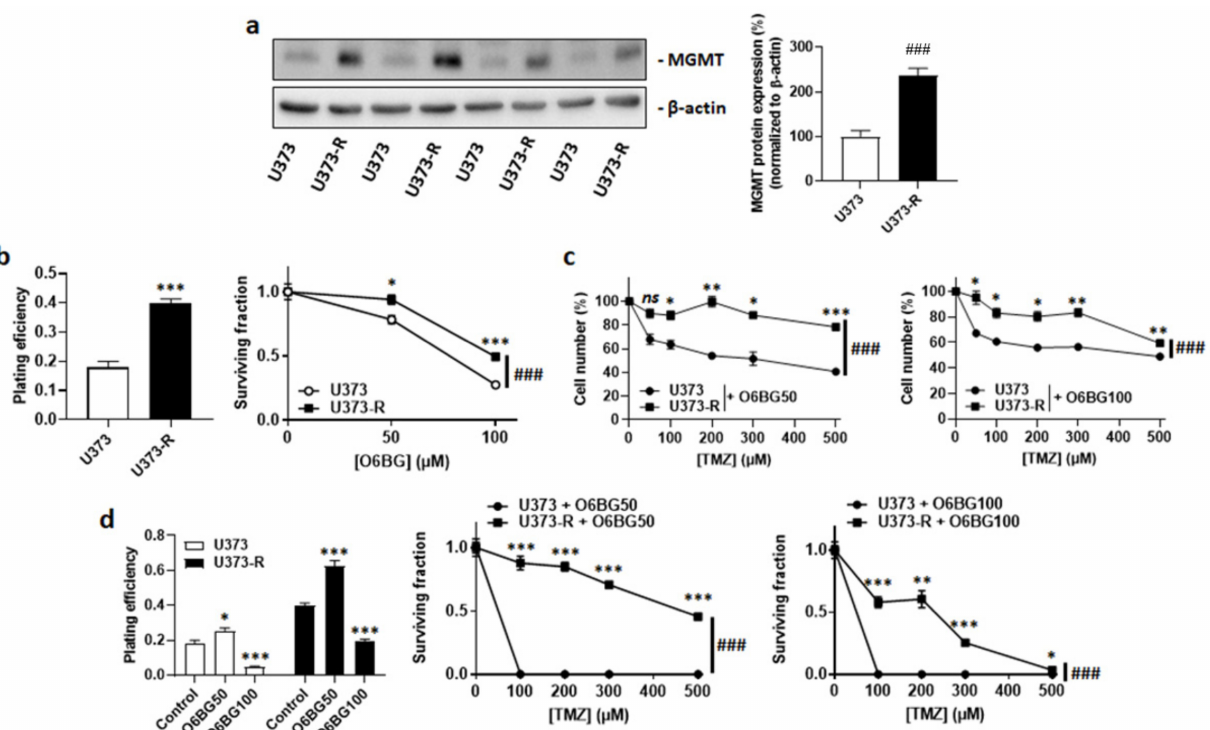
Figure 2. High MGMT protein expression does not account for TMZ resistance in the U373/U373-R isogenic human glioblas- toma model. ( a ) O6-methylguanine DNA methyltransferase (MGMT) and β -actin (loading control) protein expression as determined by Western blotting in U373 and U373-R glioblastoma cells in the absence of TMZ, with pictures on the left and quantification on the right ( n = 4). ( b ) Clonogenic assays of the cells that were pretreated for 72 h with increasing concentrations of MGMT inhibitor O6-benzylguanine (O6BG). Displayed are the plating efficiency of the vehicle-treated cells at 72 h ( left ; n = 6); and the surviving fraction ( right ; n = 6–12), where the data are normalized to the number of corresponding vehicle-treated cells. ( c ) Number of cells 72 h after treatment with the indicated concentrations of TMZ in combination with 50 µ M O6BG (O6BG50; left ; n = 4) or 100 µ M O6BG (O6BG100; right ; n = 4). ( d ) Clonogenic assays of the cells that were pretreated for 72 h with increasing concentrations of TMZ and O6BG. Displayed are the plating efficiency of the cells that were treated ± O6BG ( left ; n = 6); and the surviving fractions of the cells that received O6BG50 ( middle ; n = 6) or O6BG100 ( right ; n = 5–6), where the data are normalized to the number of corresponding vehicle-treated cells. All data are shown as means ± SEM. * p < 0.05, ** p < 0.01, *** p < 0.005, ns: p > 0.05 versus the corresponding control; ### p < 0.005 for whole curve comparison; by Student’s t -test ( a , b left ), two-way ANOVA with Sidak’s post hoc test ( b right , c , d middle , d right ), or one-way ANOVA with Dunnett’s post hoc test ( d left